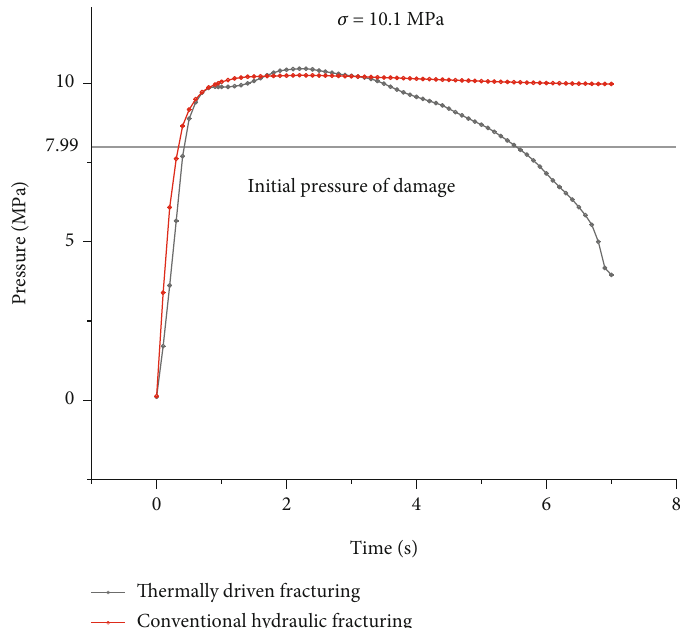
Figure 15: Pressure variation curves of thermally driven fracturing and hydraulic fracturing for a rock tensile strength of 10.1MPa.